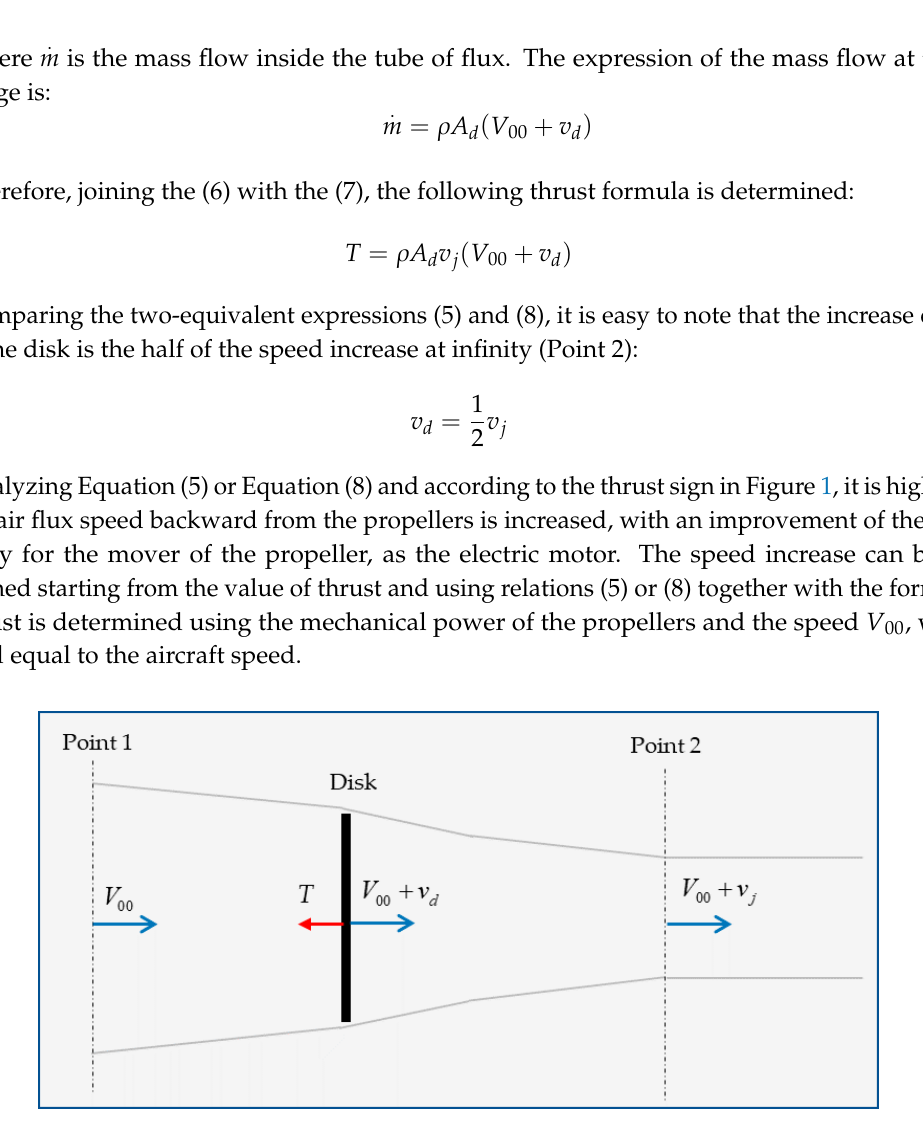
Figure 1. Single impulsive theory model adopted for the air flow calculation along the electric motor.